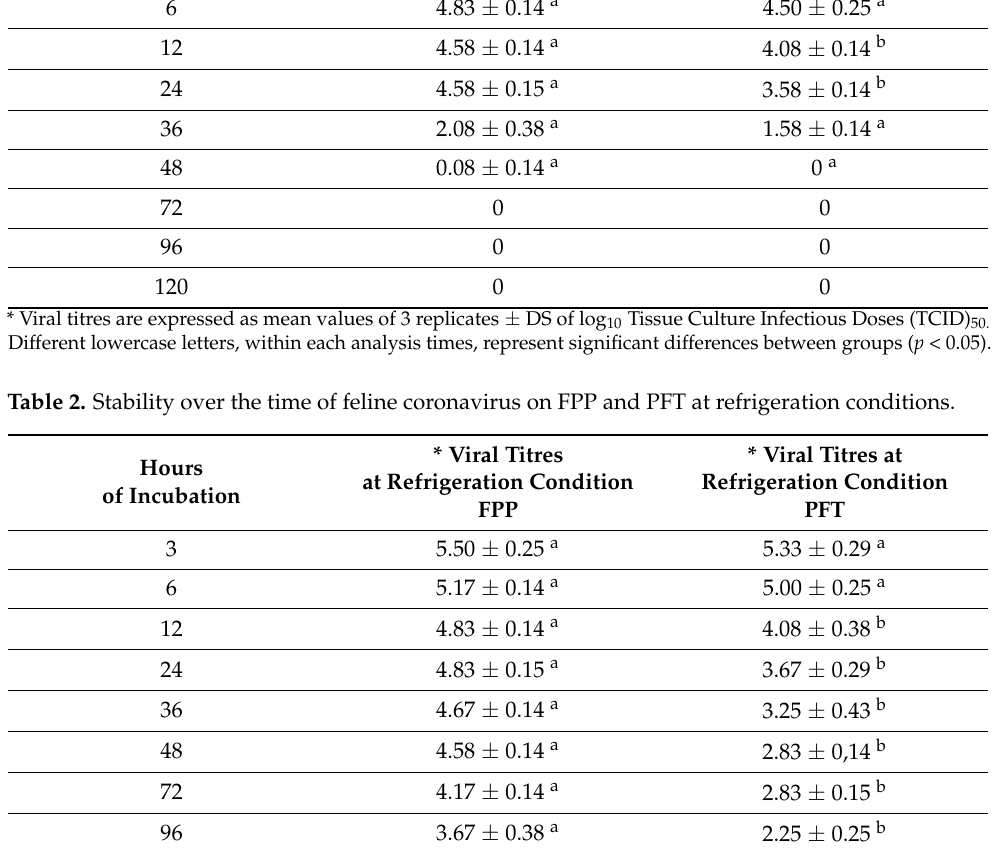
Table 1. Stability over the time of feline coronavirus on flow-pack polyethylene (FPP) and polystyrene food trays (PFT) at room temperature.